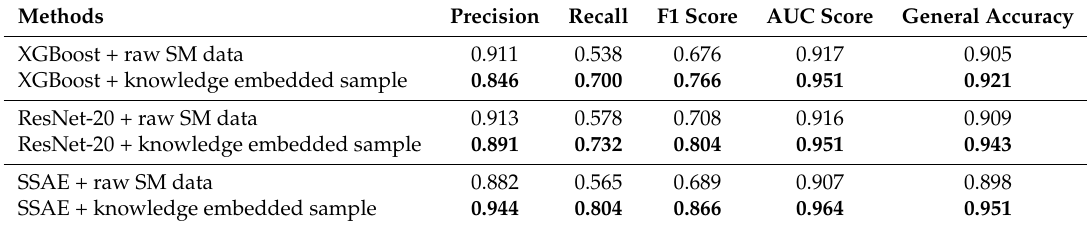
Table 3. Comparison about sample embedded knowledge or